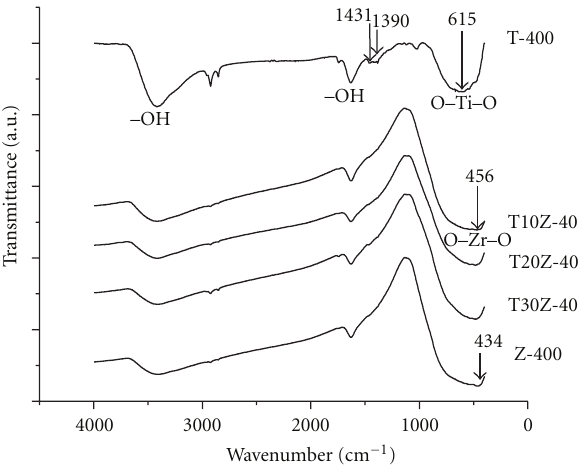
Figure 2: FT-IR spectra of T10Z-400, T20Z-400, T30Z-400, T-400, and Z-400 samples. Table 1: Wave number of the main registered